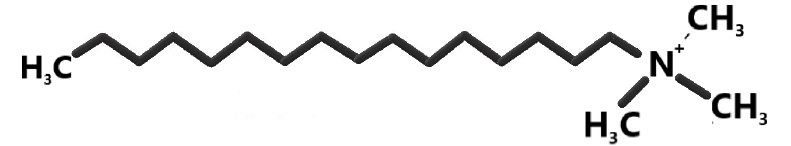
Figure 1. Structural structure diagram of the HDTMA molecule.